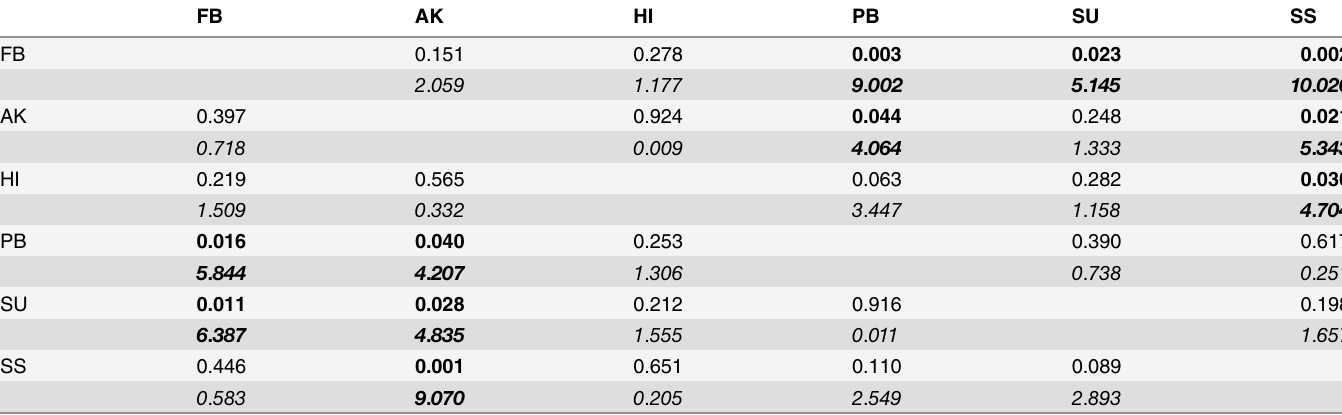
Above the diagonal refers to comparisons made for δ 15 N values. Below the diagonal refers to comparisons made for δ 13 C values. For each cell, the top number is the p-value and the bottom number (in italics) is the Chi 2 value. P-values < 0.05 and associated chi-square values are in bold. FB = failed breeders. AK = Alaska fi sheries-associated birds. HI = Hawaii fi sheries-associated birds. PB = prebreeders. SU = sequentially unsuccessful breeders. SS = sequentially successful breeders. Sample size of each category reported in Table